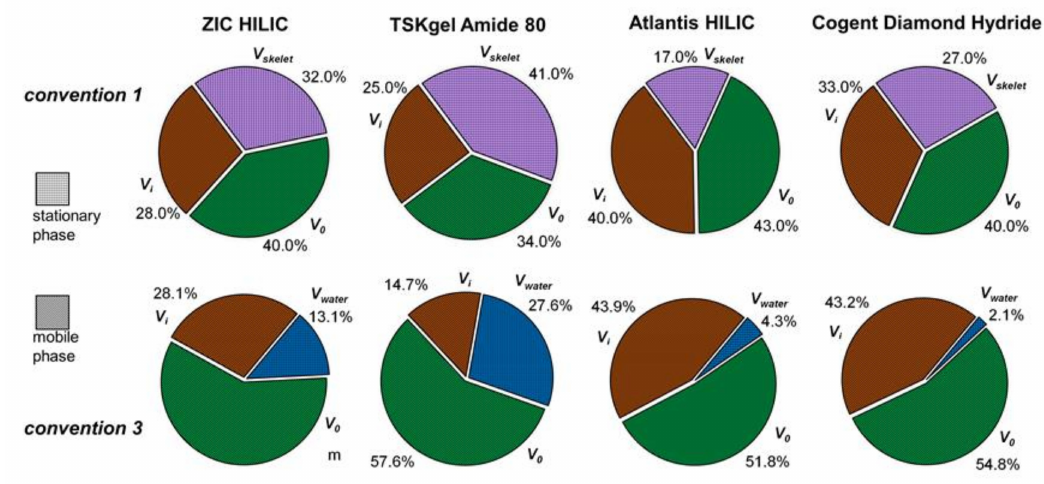
Figure 4. Distribution of the areas in the columns: skeleton, adsorbed water, inner pores, inter-particle space, stationary and mobile phases in four polar columns: Zic HILIC, TSKgel Amide 80, Atlantis HILIC and Cogent Diamond Hydride.